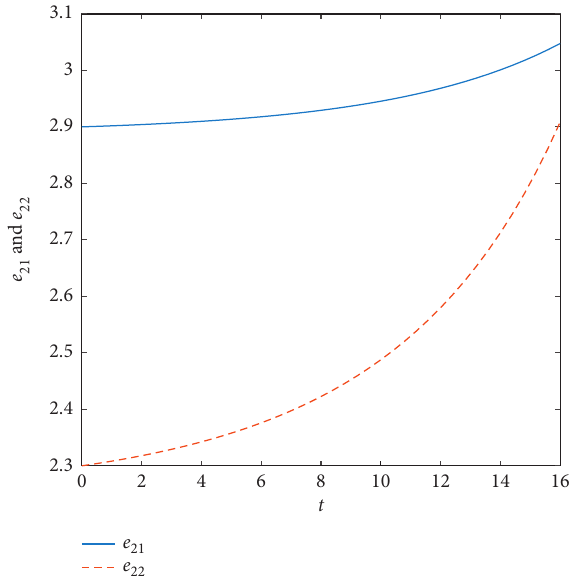
Figure 5: The pollution emission trajectory of the downstream region under